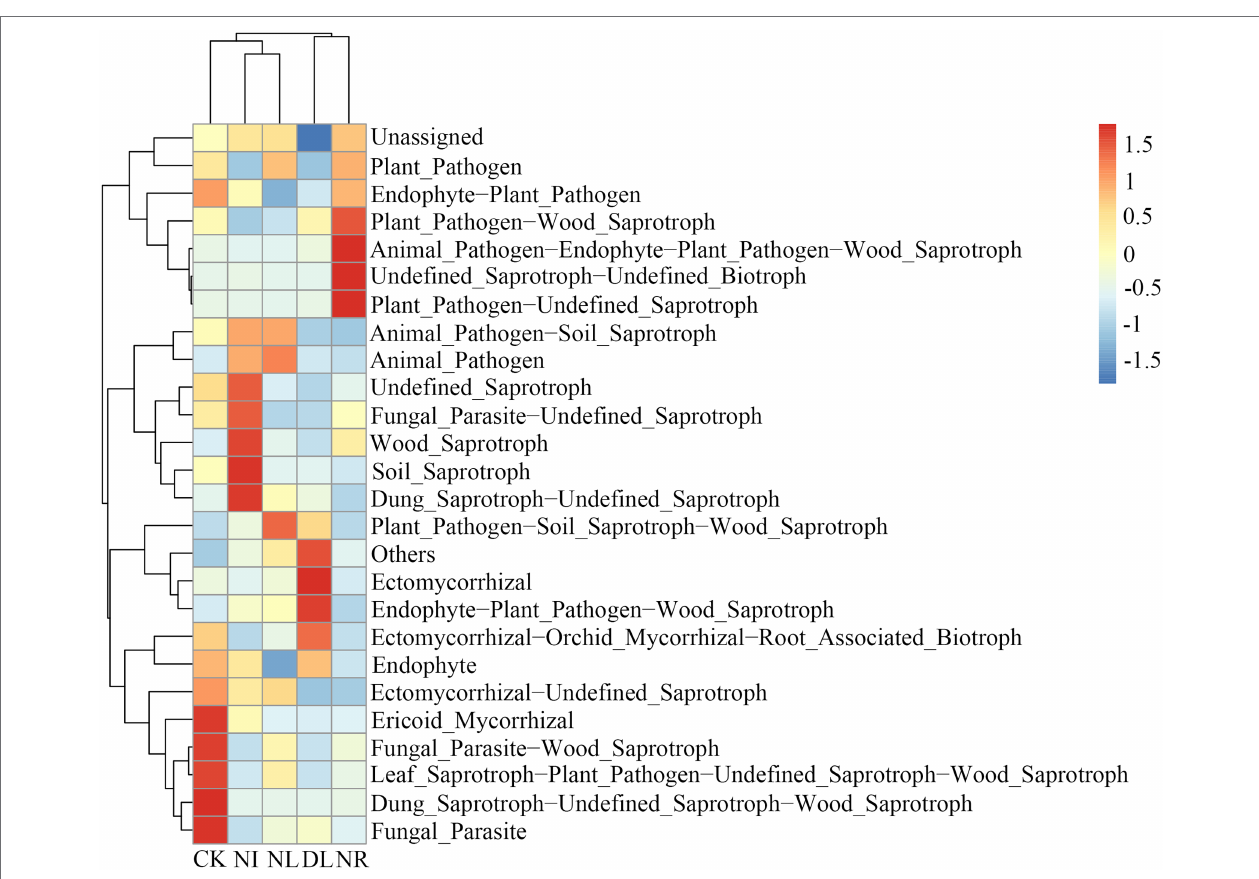
FIGURE 7 | Changes in functional groups of soil fungi under different treatments. CK, DL, NL, NR, and NI represent control, doubled litter input, litter removal, root exclusion, root and litter exclusion,